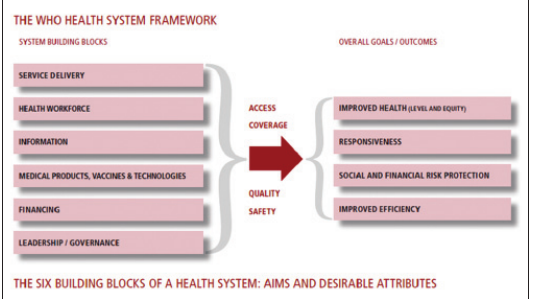
Figure 3 . The World Health Organization Health System